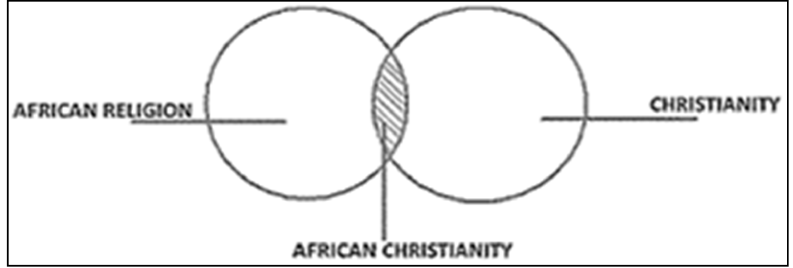
Figure 1. The nature of African Christianity. Source: Mndende (2013). Law and Religion in South Africa: An African Traditional Perspective. Africa: An African Traditional